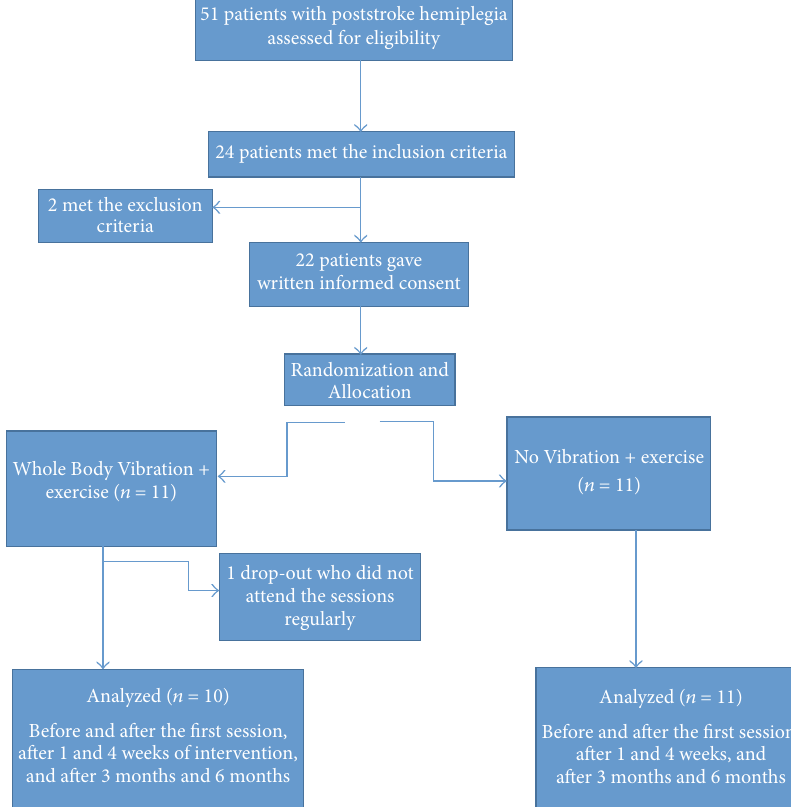
Figure 1: Patients flow